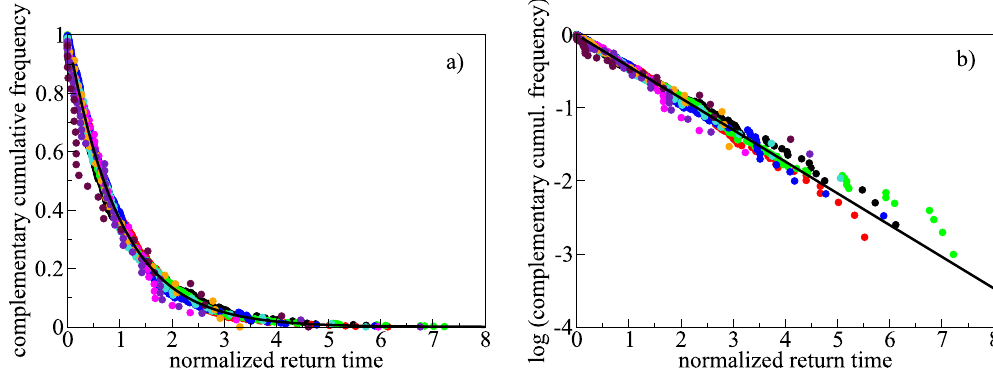
Figure 2. Exponential distribution of return times. ( a ) Complementary cumulative frequency distribution of normalized return times, for eruptions of any VEI from present time (mid-September 2017) back to the limit time reported, for each VEI class, in the panels of Fig. 1. ( b ) Same plot as for panel a, on a logarithmic vertical scale to highlight the linear trend corresponding to exponential distribution. Non-normalized distributions for each VEI class, including error bars, are shown in Supplementary Fig. 1. The two panels show that the return times from the 2550 eruptions lying close to the approximately linear trends in Fig. 1 approximate exponential distributions (theoretical exponential distributions are reported as thick black lines). Normalization on the horizontal axis is done with respect to the mean return time for each VEI class, corresponding to the inverse of the rate parameter λ in Table 2. A value of 1 corresponds to the mean return time (or inverse of the rate parameter of the distribution) for each VEI class. Computed p-values (see Methods, and Supplementary Fig. 1) are > 0.4 for all VEI classes, providing statistical robustness to the exponential distribution hypothesis. Colors of symbols: black = VEI 0; red = VEI 1; green = VEI 2; blue = VEI 3; turquoise = VEI 4; magenta = VEI 5; orange = VEI 6; indigo = VEI 7; maroon = VEI 8.